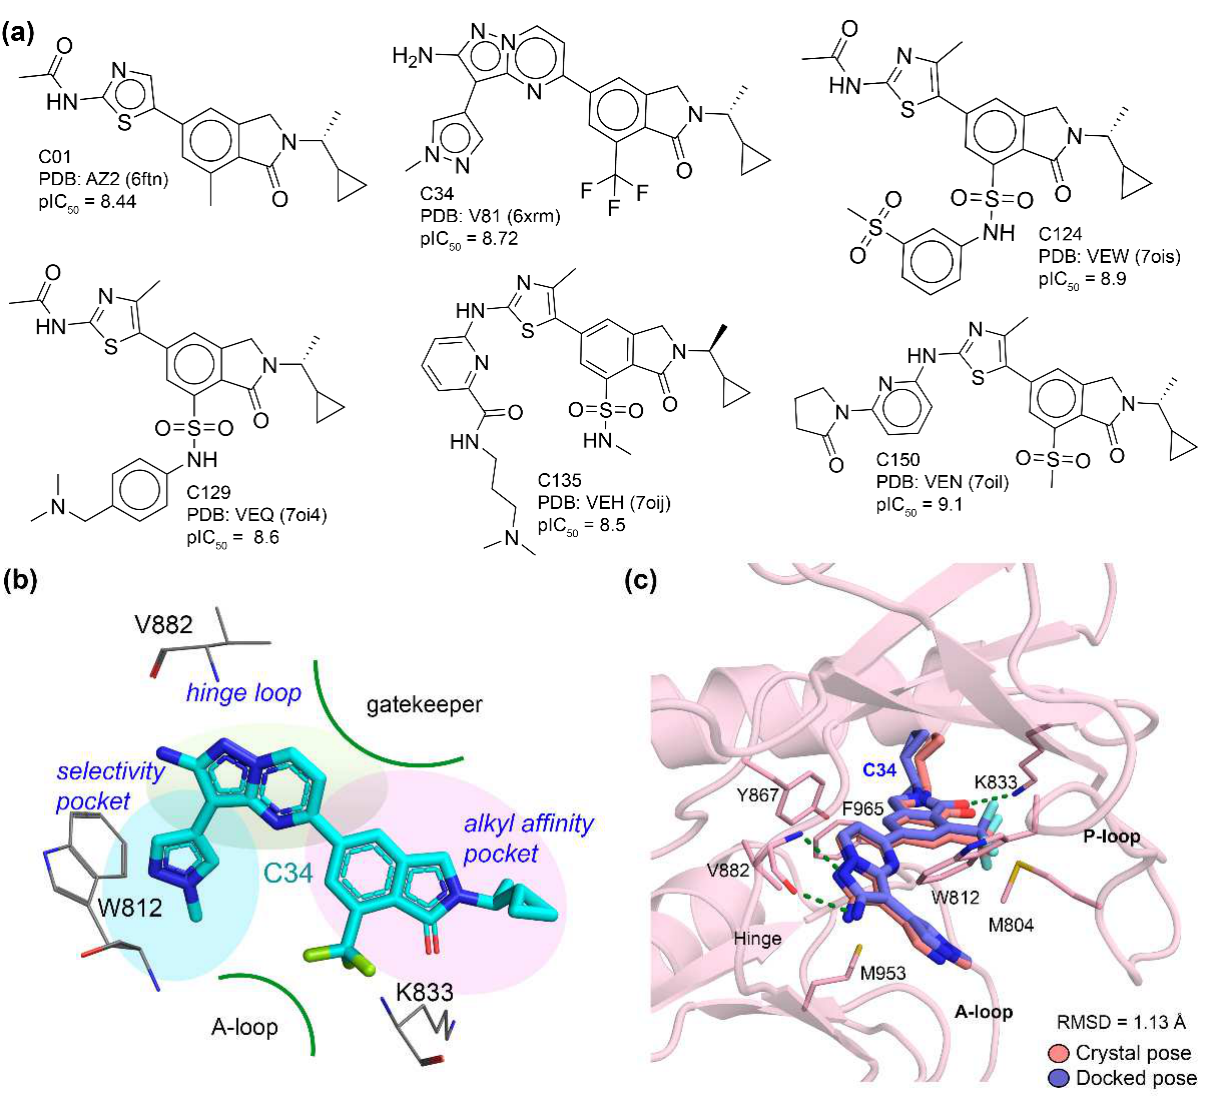
Figure 2. ( a ) 2D structure of the PI3K γ inhibitors that are available in their biological form in the RCSB PDB database and present in our dataset. The compound’s number, their X-ray crys- tallographic code, and inhibitory activity against PI3K γ are shown. Compounds C01 (PDB: 6ftn), C124 (PDB: 7ois), C129 (PDB: 7oij), and C150 (PDB: 7oil) were bound with mouse PI3K δ , whereas C34 (PDB: 6xrm) was bound with human PI3K γ . ( b ) Structural characteristics of the γ -selective PI3K inhibitors. The compounds were designed to interact with the hinge region, the alkyl affinity pocket, and the selectivity pocket. ( c ) Self-docking of compound C34 with PI3K γ inside the ATP binding pocket. The docking process was able to reconstruct the crystal pose of C34 with an RMSD of 1.13 Å in our study. The H-bonds with residues K833 and V882 are shown by dotted green lines.